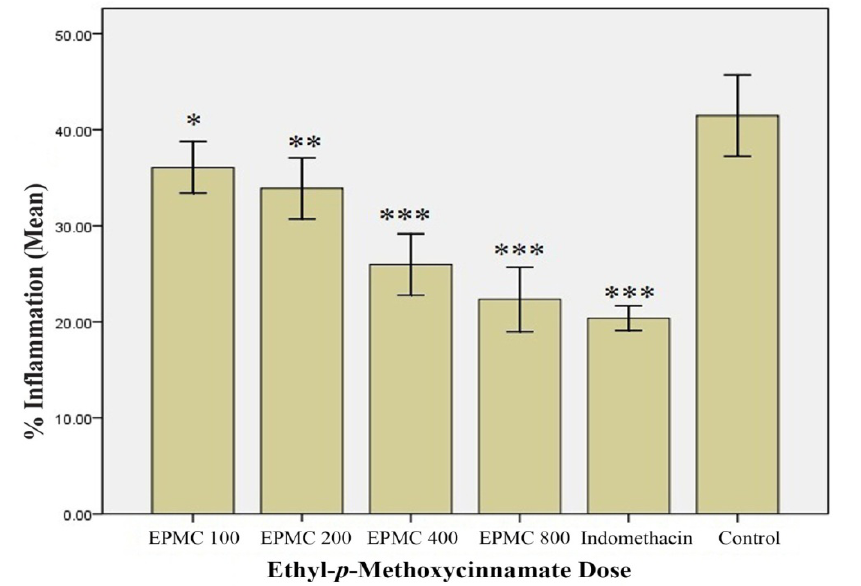
Figure 5. Percentage (%) inflammation observed in ethyl- p -methoxycinnamate (EPMC)-treated rats after 3rd h of carrageenan administration (n = 6). EPMC 100, EPMC 200, EPMC 400 and EPMC 800 indicate ethyl- p -methoxycinnamate in dose of 100 mg, 200 mg, 400 mg and 800